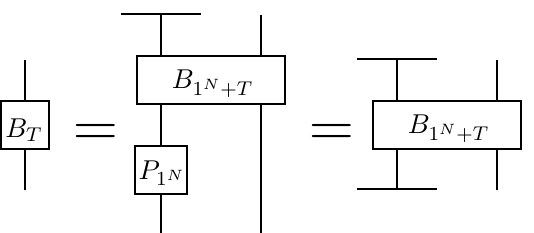
multiplied by the projector P . B has N + 2 q 1 N + T 1 N 1 N + T